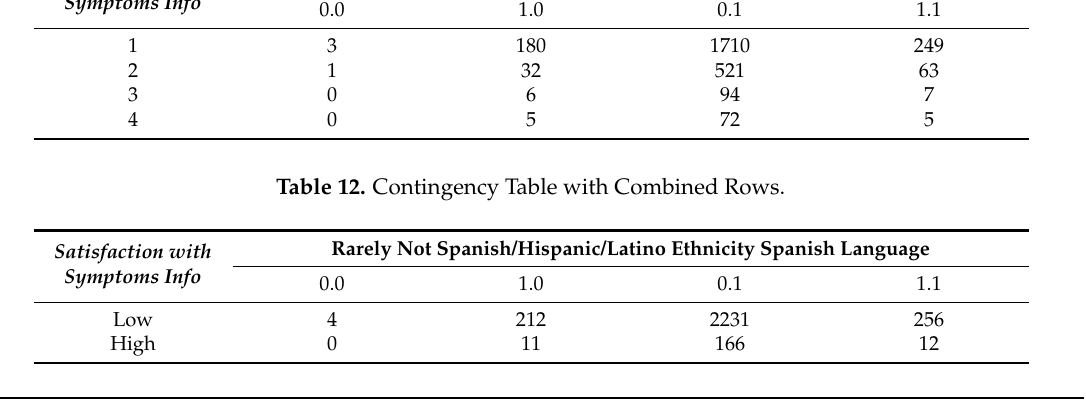
Algorithm 4. Modified chi-square